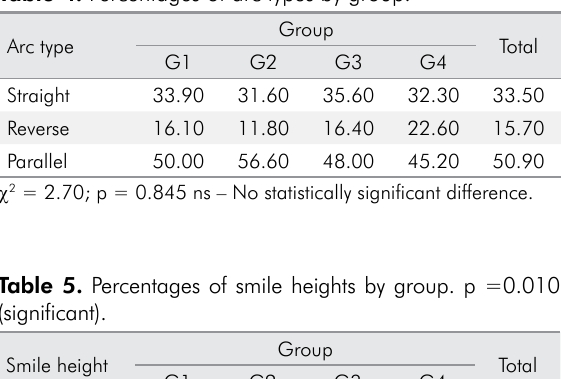
Table 4. Percentages of arc types by group.